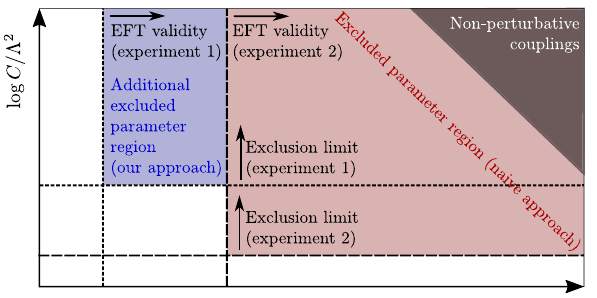
Fig. 1 Illustration of our approach for studying DM EFTs compared to a more naive approach, in which one only uses the experiment that yieldsthestrongestboundon C /(cid:2) 2 .Theresultingexclusionisindicated by the red shaded region. By independently varying (cid:2) , we can include additional information from experiments that give weaker bounds on C /(cid:2) 2 butforwhichtheEFThasalargerrangeofvalidity.Theadditional exclusion obtained in this way is indicated by the blue shaded region. The region of parameter space that corresponds to the non-perturbative values of Wilson coefficient C is excluded in either approach (shaded